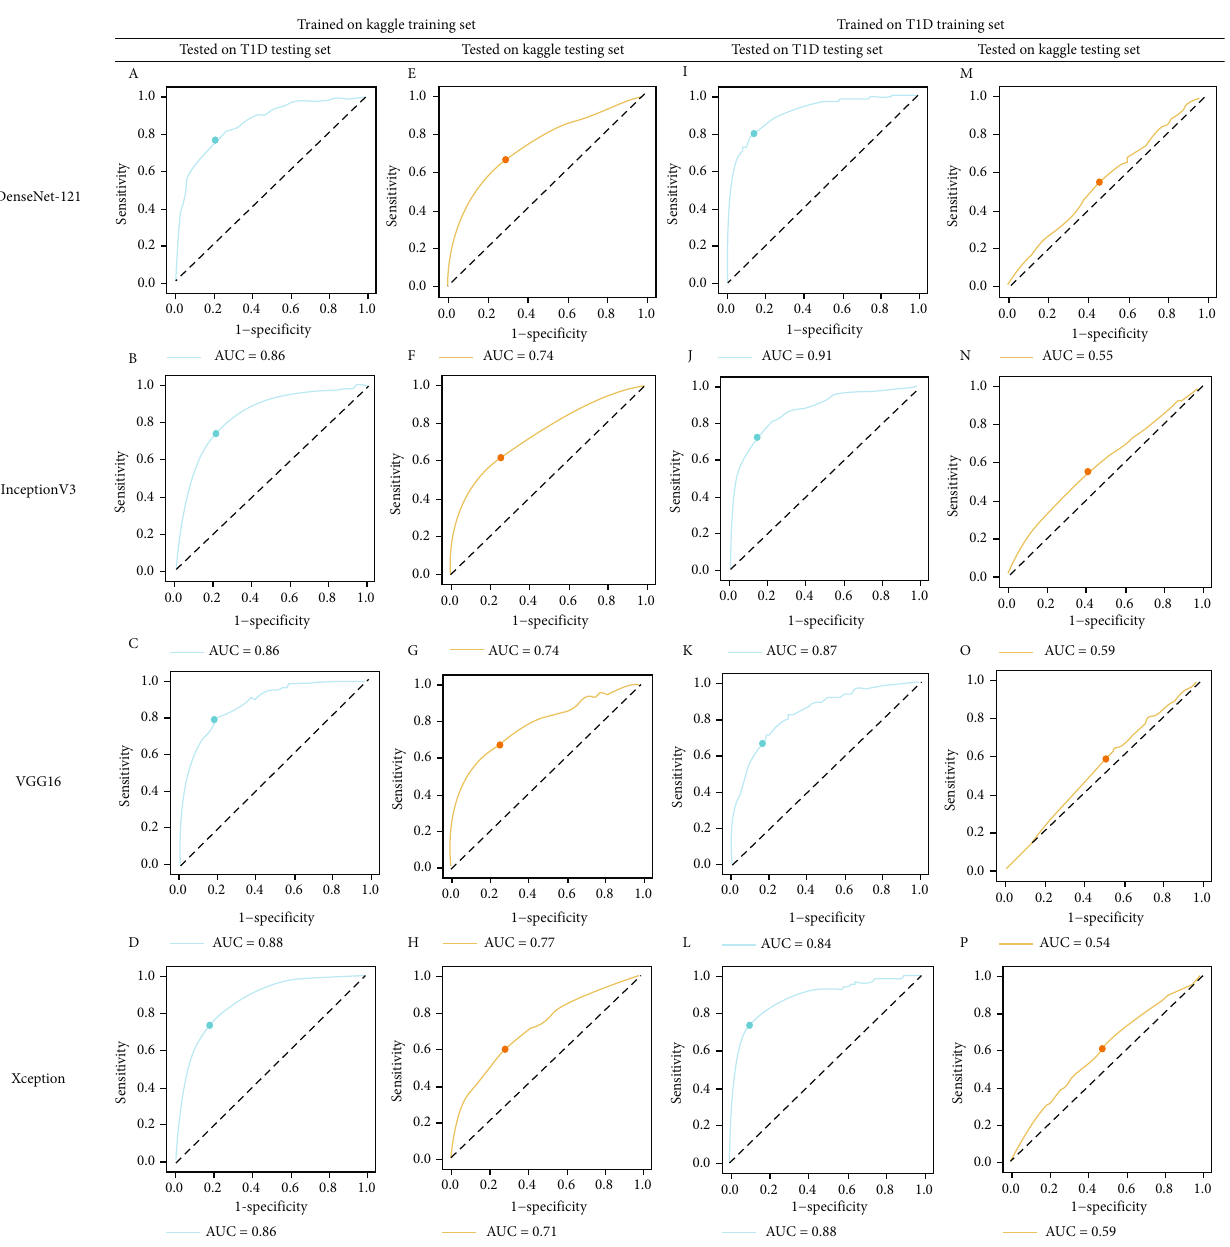
Figure 3: Receiver operating characteristic (ROC) curves of di ff erent transfer learning models in predicting diabetic retinopathy. The ROC curve of models that were tested with the type 1 diabetes (T1D) testing set was plotted in blue, whereas those tested with the Kaggle testing set were plotted in orange. The point on the ROC curve was the selected threshold. (e) – (h) There was a signi fi cant decrease in AUC when models previously trained with the T1D training set were tested with the Kaggle dataset. (i) – (l) The models that were previously trained with the Kaggle training set have a more robust performance when tested with the T1D testing